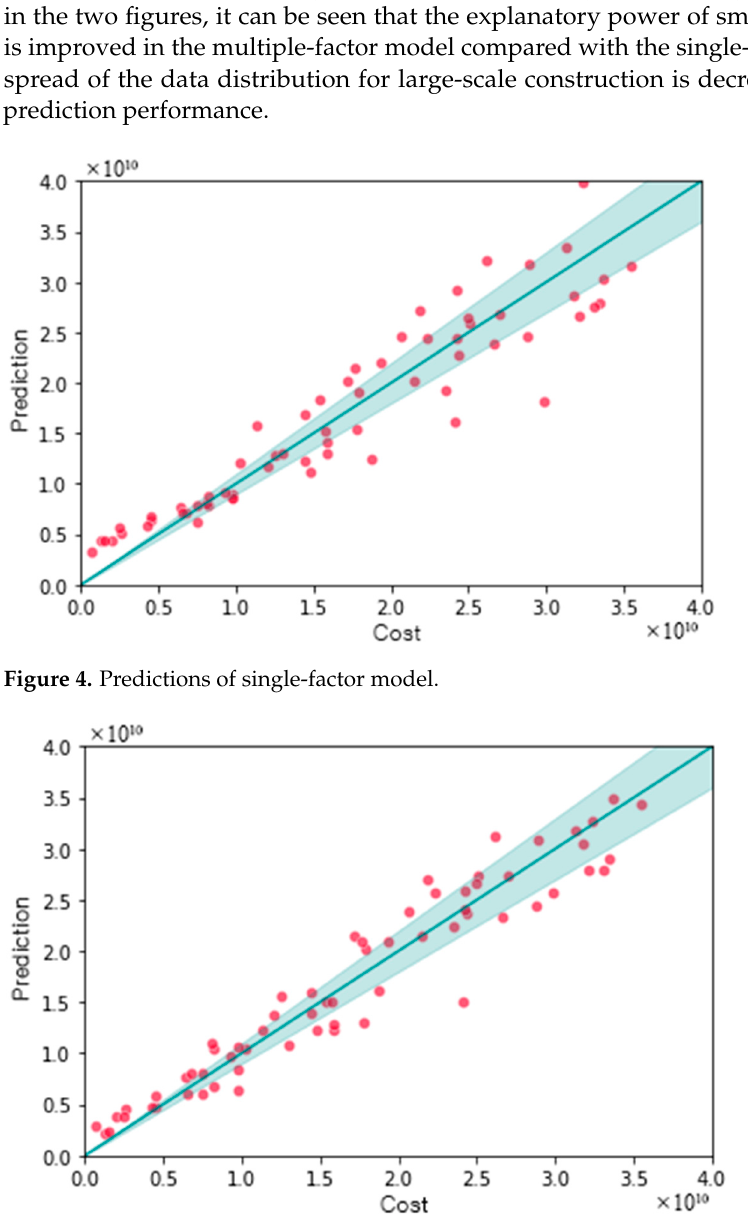
Figure 5. Predictions of multiple-factor model.